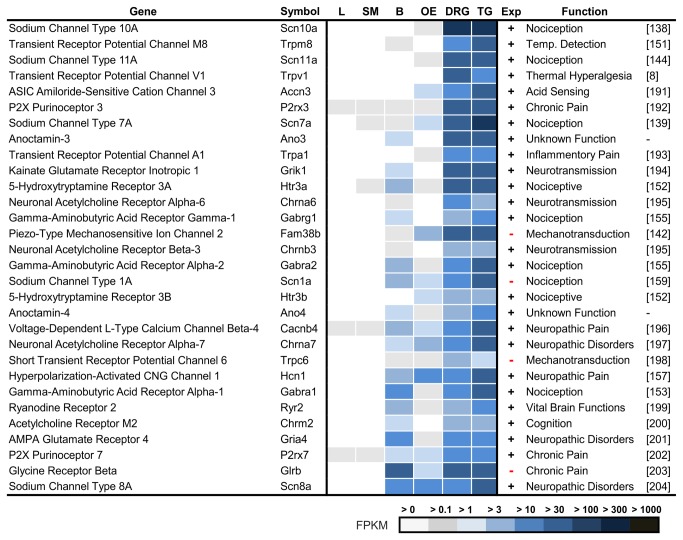
Ranking of TG- and DRG-specific ion channels.We compared the expression levels of the most specific ion channels of the TG and DRG with those in the brain (B), liver (L), olfactory epithelium (OE), and skeletal muscle (SM). Four previously unreported ion channels could be identified among the 30 most specific ion channels in the TG (marked with (-)). Most ion channels are involved in TG thermosensation, mechanosensation and pain perception.